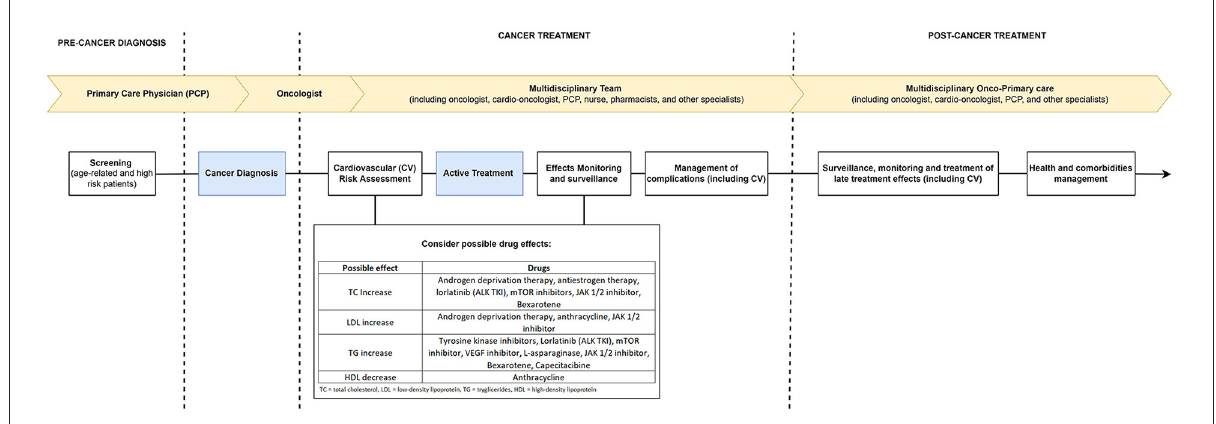
FIGURE1 Suggested care framework for cancer patients with multidisciplinary